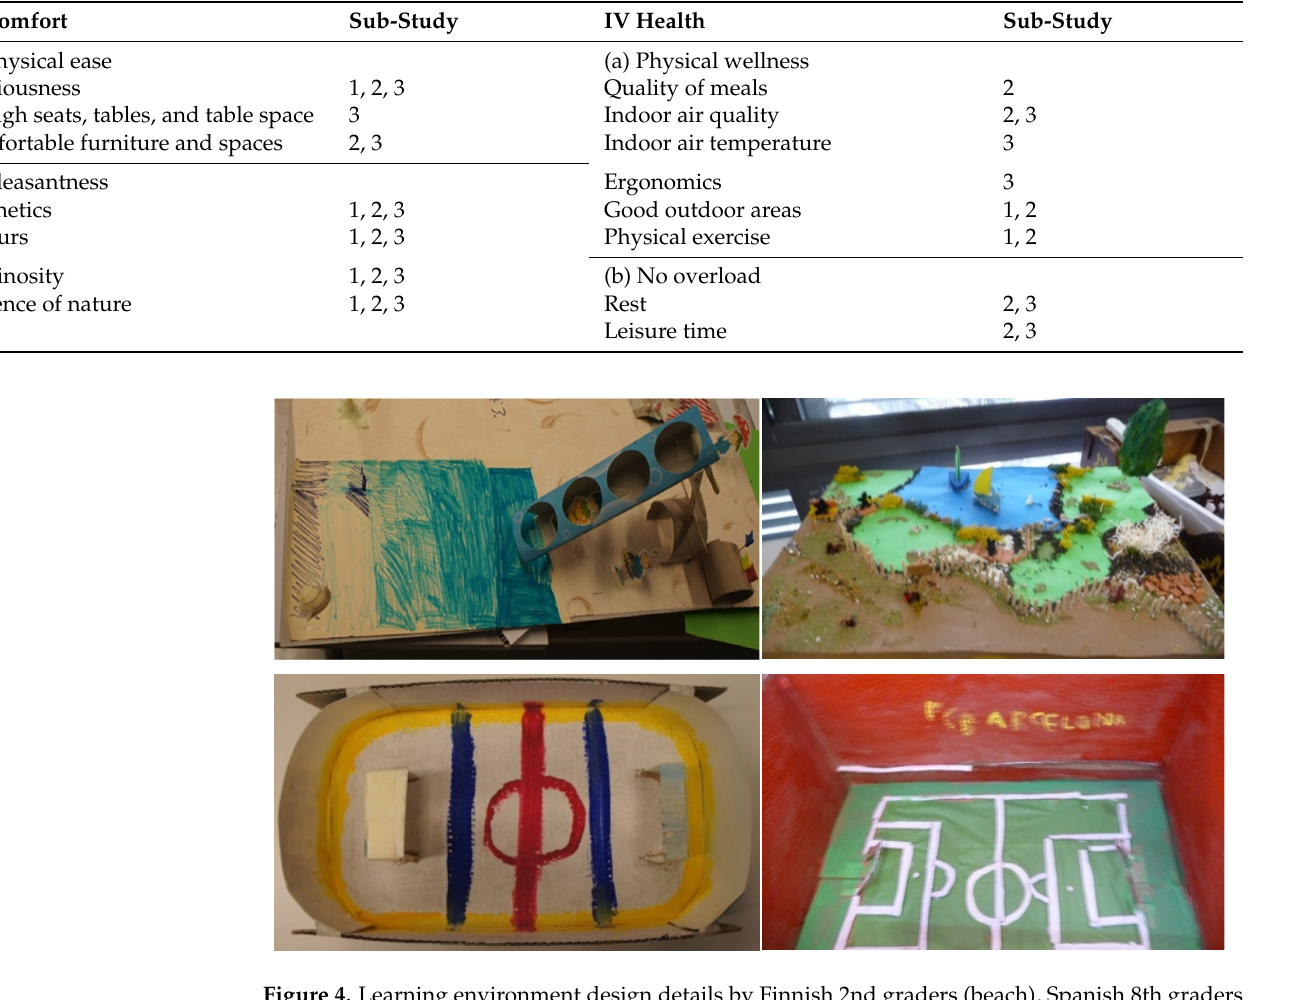
Table 3. Comfort- and health-related characteristics confirmed or emerged in sub-studies.